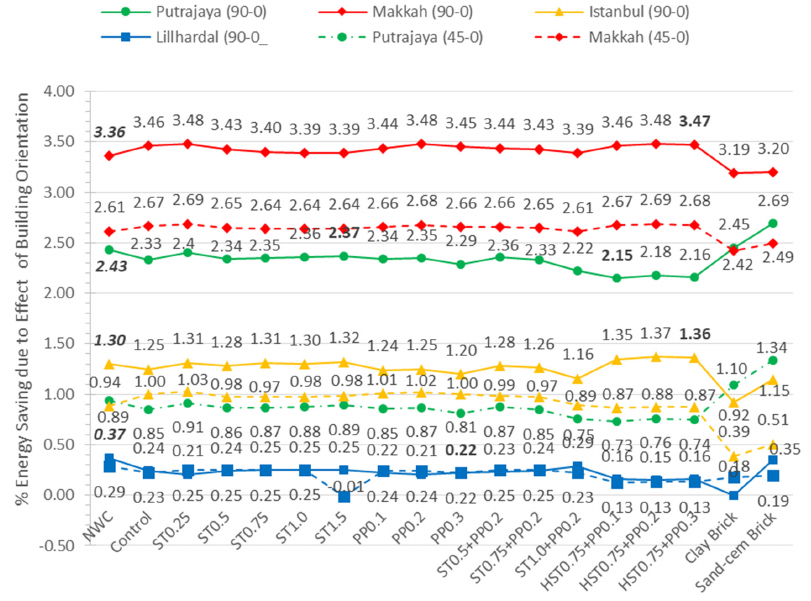
Figure 11. Energy-savings because of building orientations to the base model.